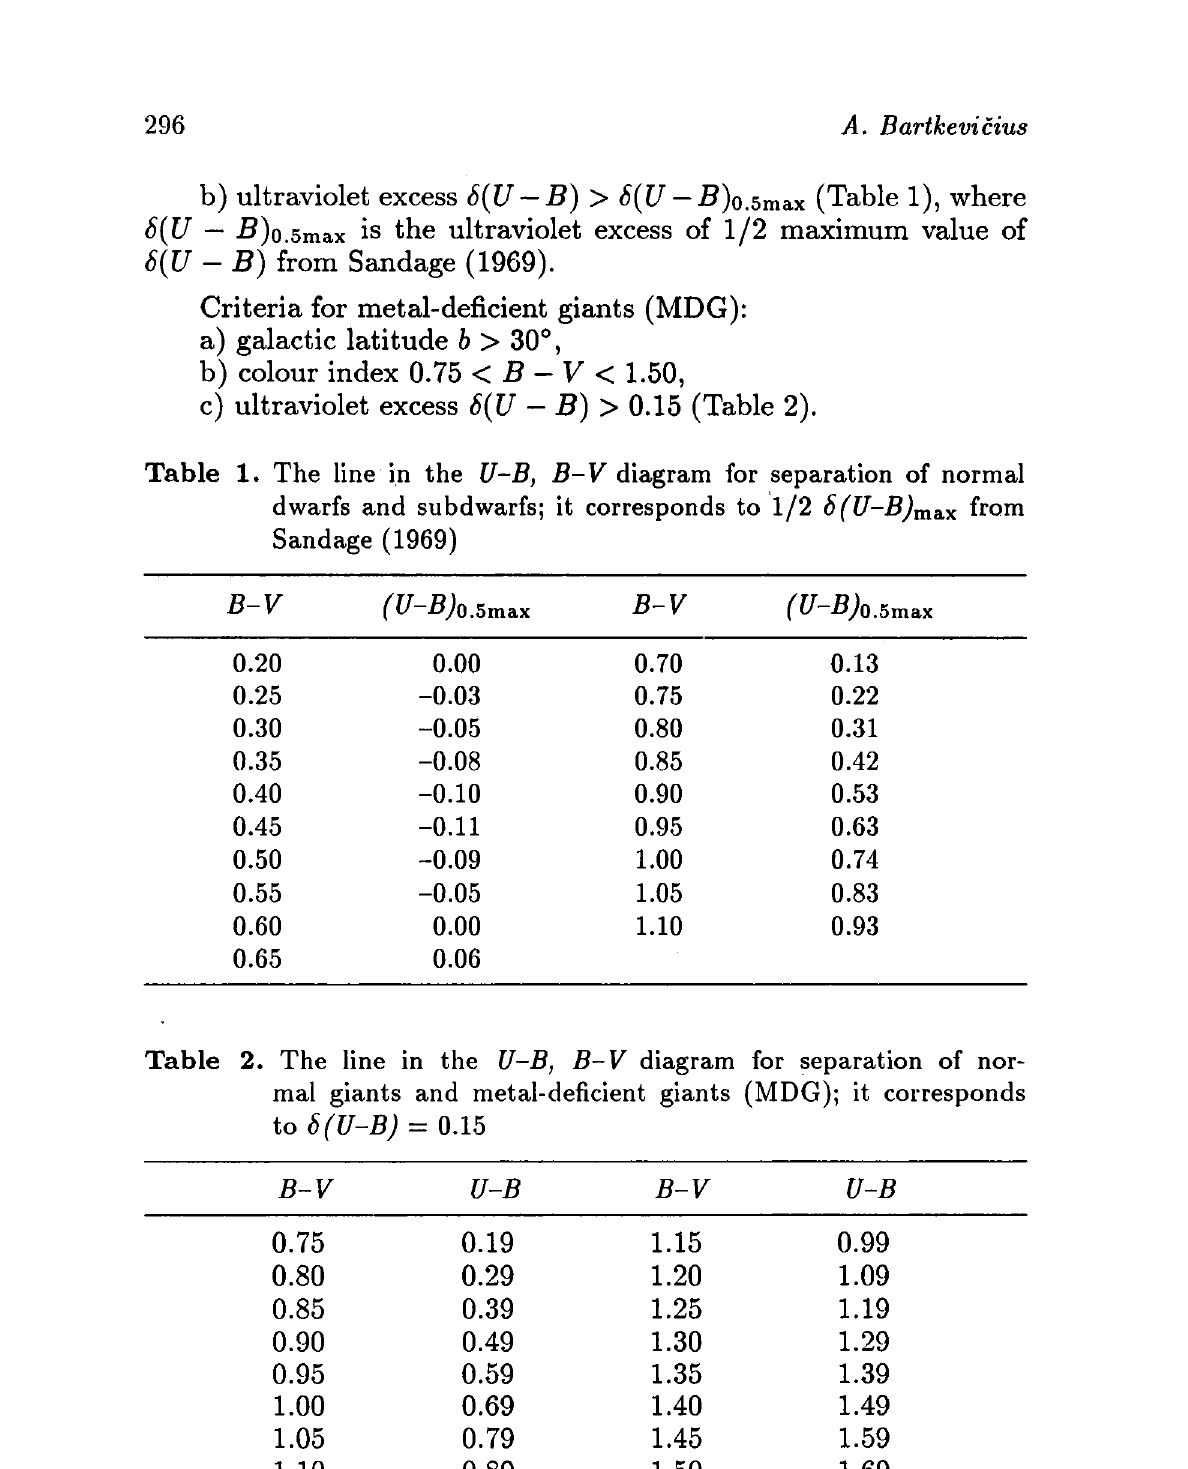
Table 2. The line in the U-B, B-V diagram for separation of